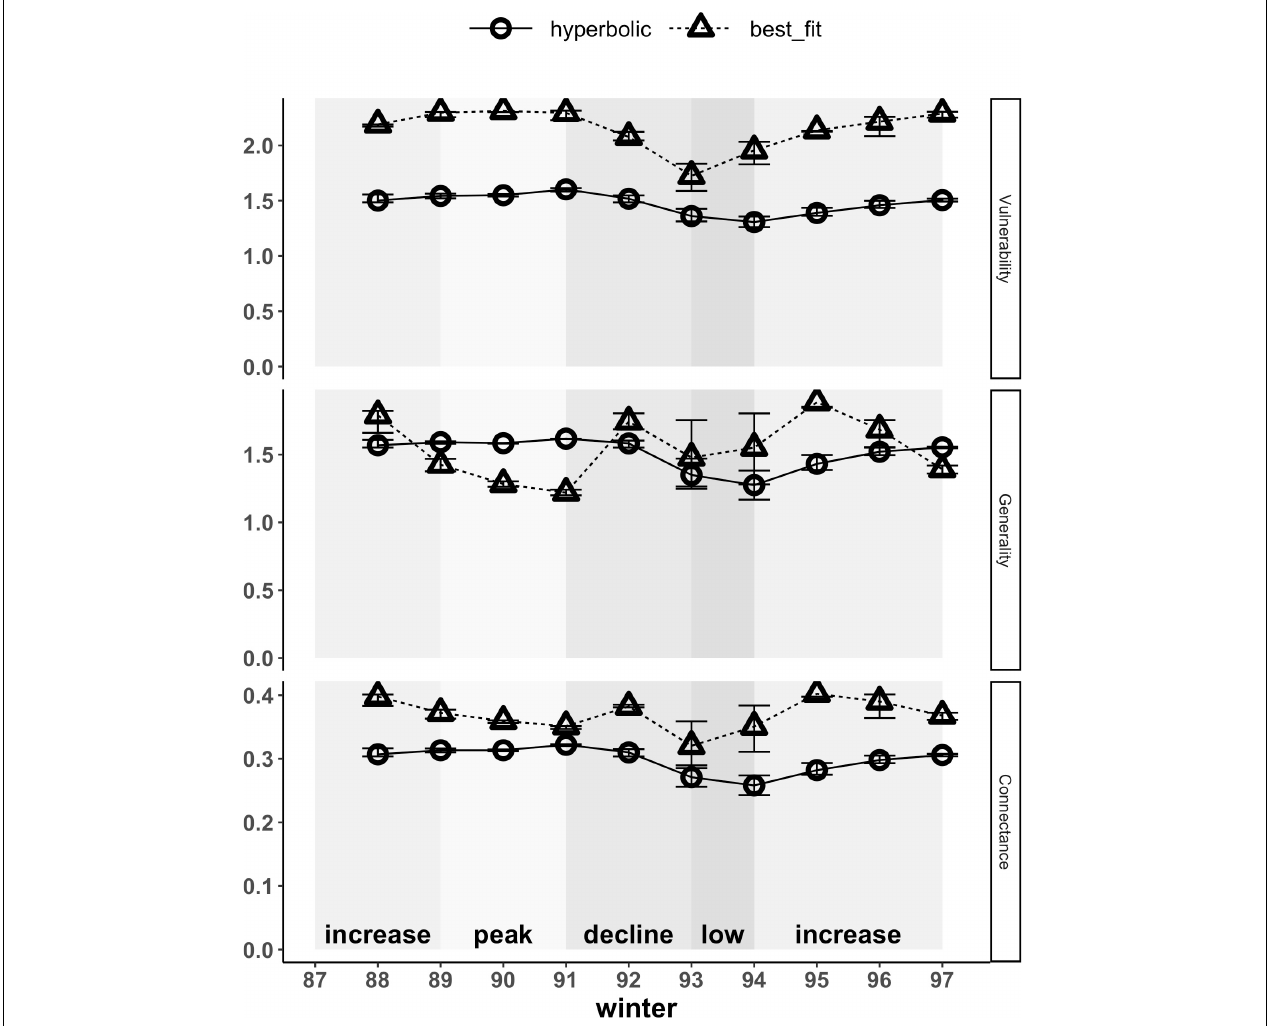
FIGURE 7 | Weighted network-level metrics (vulnerability, generality and connectance) based on hyperbolic and best-fit functional response models. At the network level, vulnerability and generality represent the averages of node-level estimates across all prey and predators, respectively, weighted by per capita kill rates. Connectance reflects the diversity of kill rates across the network and is similarly weighted by per capita kill rates; higher values indicate a more even distribution of kill rates across prey and predators in the food web. Error bars show uncertainty in network-level metrics based on upper and lower limits of 95% confidence intervals for hare density estimates. Shading indicates phases of the cycle as defined by hare